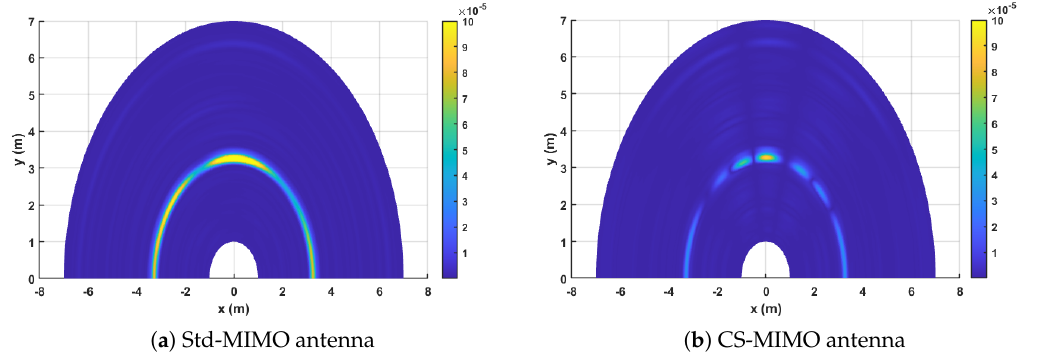
Figure 7. Radar images of a corner reflector placed in front of the MIMO